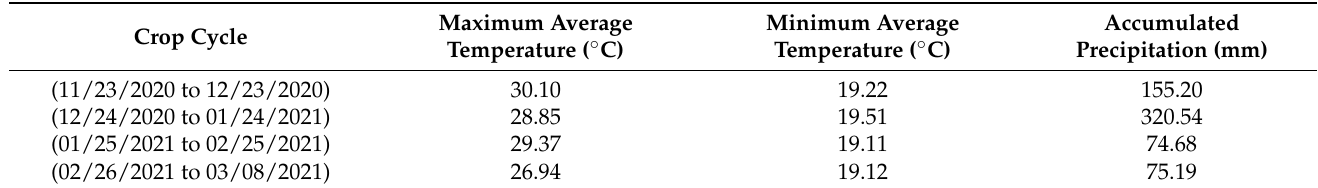
Table 1. Climate conditions from transplanting to harvest time of vegetable and type soybean cultivar grain soybeans for edamame production. Botucatu, SP, Brazil,